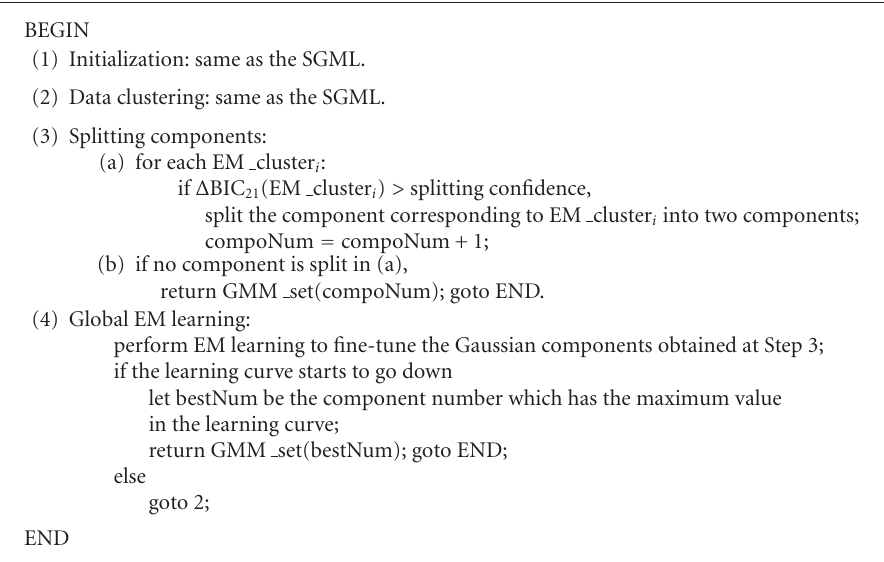
Algorithm 2: The fast SGML